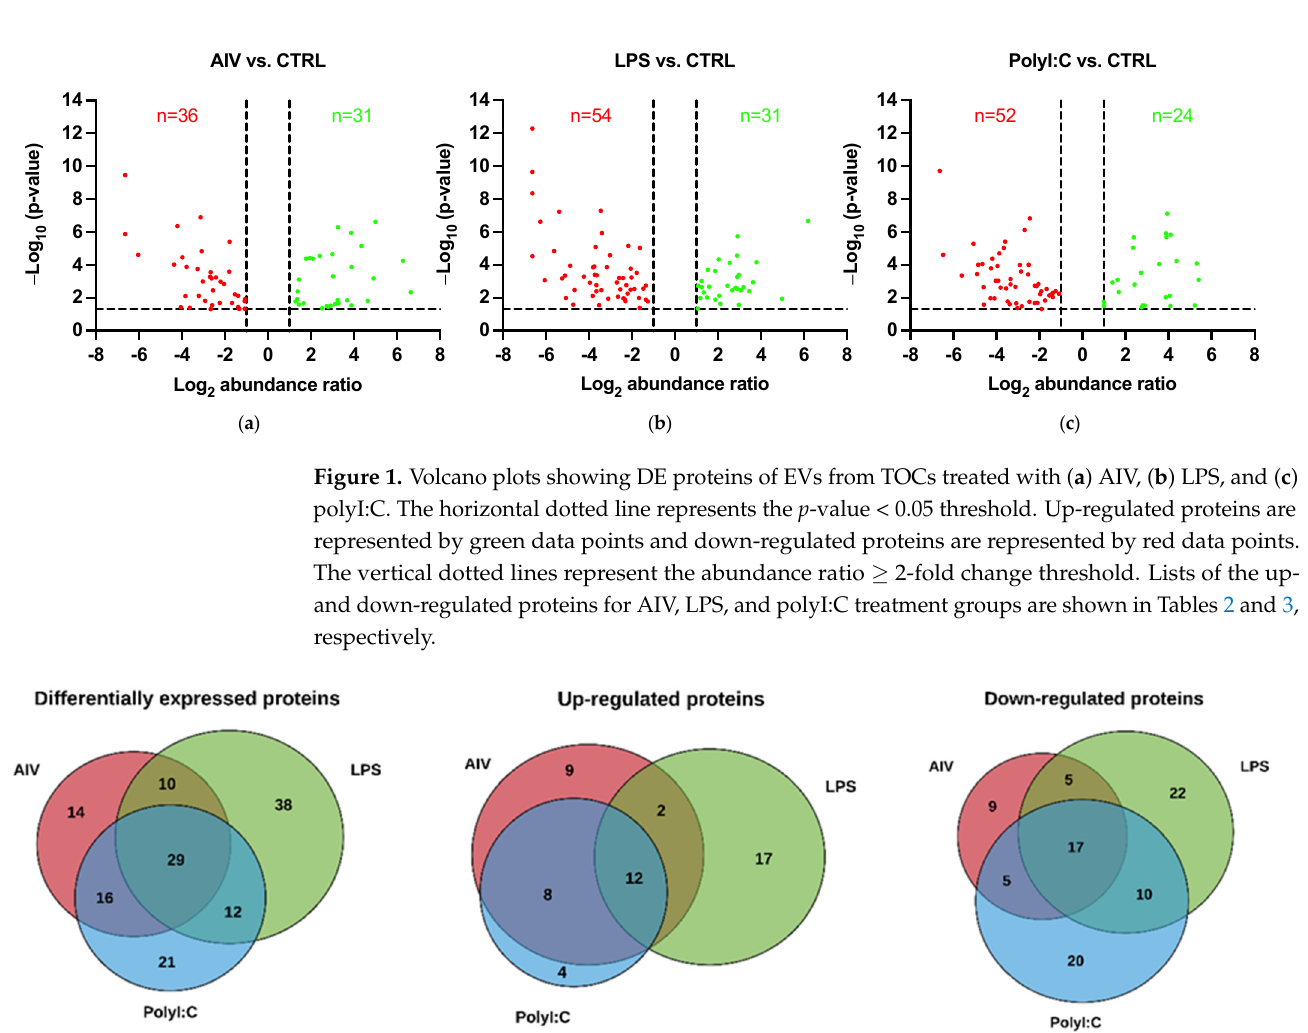
Figure 2. Venn diagram showing DE proteins of EVs from TOCs treated with ( a ) AIV, ( b ) LPS, and ( c ) polyI:C. Lists of the up- and down-regulated proteins for AIV, LPS, and polyI:C treatment groups and intersections of groups are shown in Table S2.